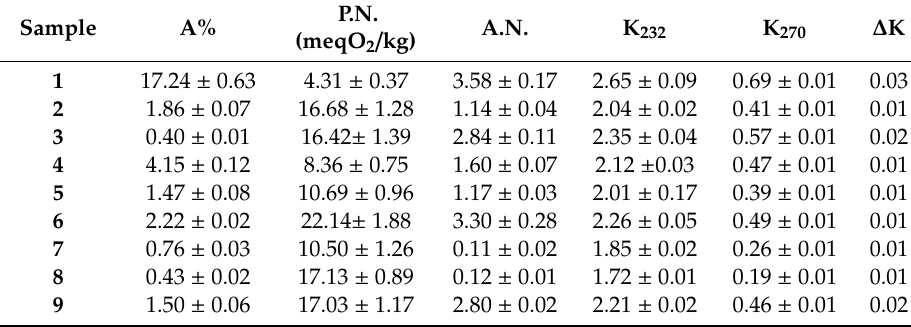
Table 2. Free acidity (A%), peroxides number (P.N.), anisidine number (A.N.), and spectrophotometric parameters (K 232 , K 270 , and ∆ K) of the analyzed hemp seed oil